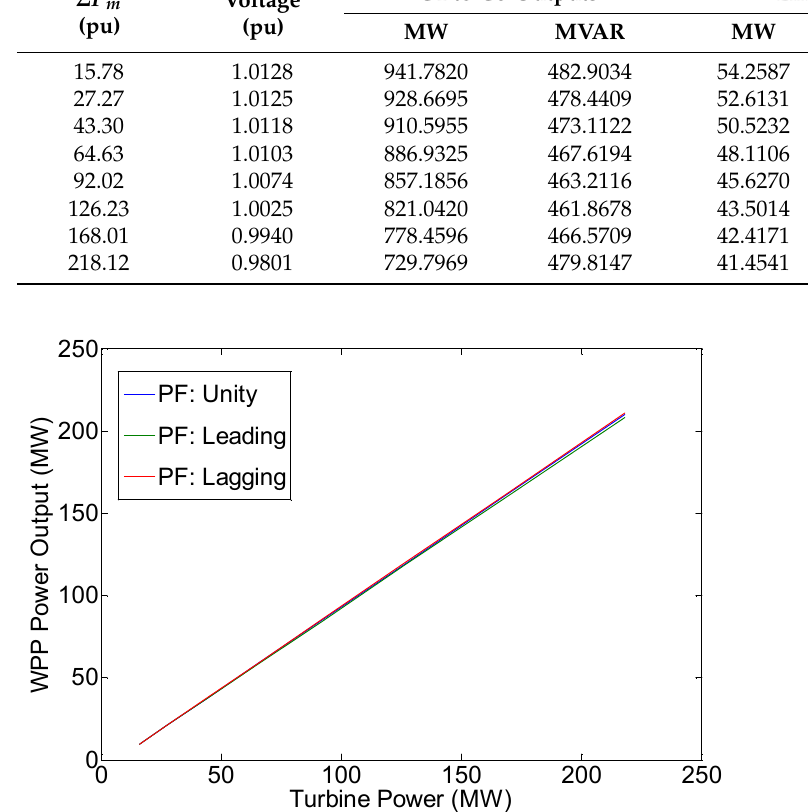
Figure 5. Variation of WPP active power output ( P g ).